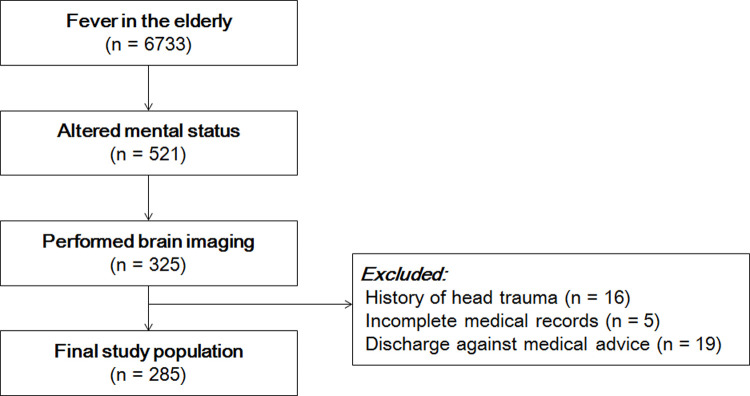
Study population.